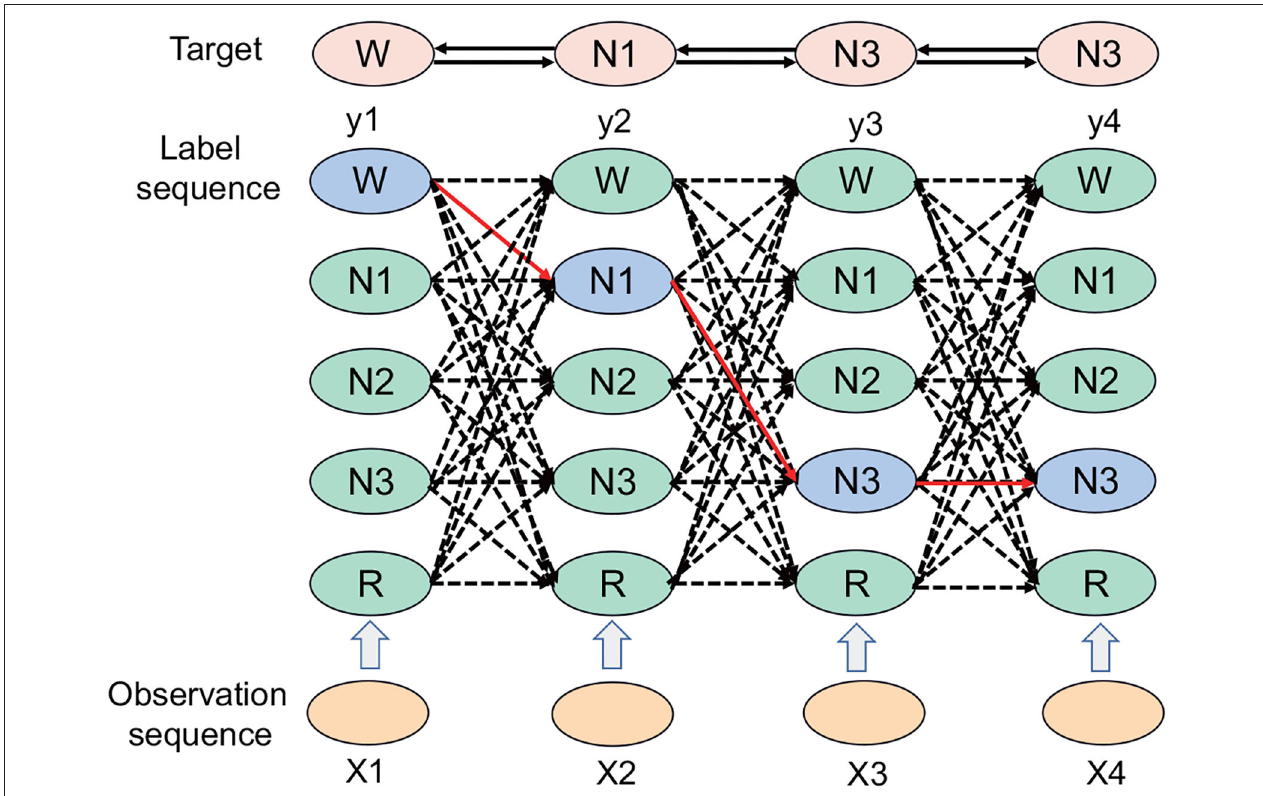
FIGURE 2 | The CRF path selection process. Each column represents a time node. There are five periods: W period, N1 period, N2 period, N3 period, and REM period; the solid black line denotes the final selected path, which includes the W, N1, N3, and N3